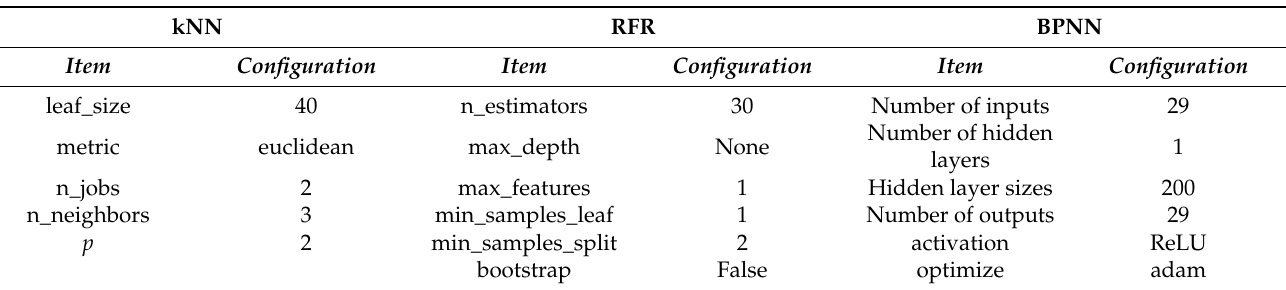
Line graphs in Figure 4 illustrate the RFR (red lines), kNN (grey lines), and BPNN (green lines) algorithms using testing data that were compared with the actual line graphs (blue lines). As far as the predicted models of labor immigration in the three nations are concerned, the BPNN lines are the nearest ones compared with the real data in Taiwan, Korea, and Japan. As a result, the grey lines show that kNN algorithms achieve the second- most accurate level in Taiwan and Japan, whereas kNN only achieves the lowest level